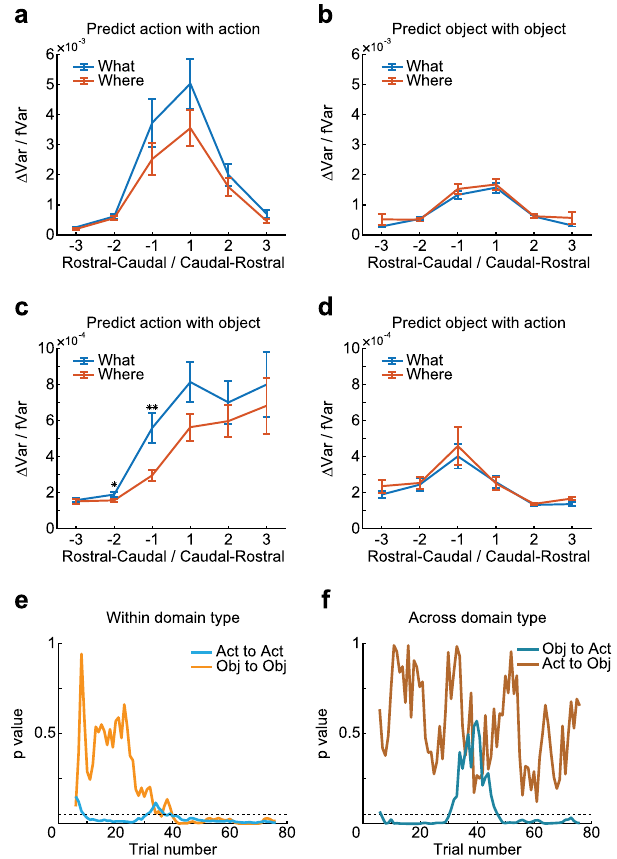
Fig. 6 Prediction of chosen action and object. a – d Contribution of arrays separated by different ordinal distances either rostral or caudal to each array to the prediction of posterior in each array. The x -axis indicates the ordinal distance (see Fig. 1d for array number) of the arrays that were dropped in the partial model. The y -axis indicates the difference of variance explained between the Partial models (i.e., when dropping one array, bilaterally) and the Full model ( Δ Var), normalized by the variance explained in the Full model (fVar). Larger values indicate a stronger prediction of the posterior from the arrays separated by distances indicated on the x -axis. The separate panels show the prediction of decoding accuracy of action with action ( a ), predicting object with an object ( b ), predicting action with an object ( c ), and predicting object with action ( d ). Rostral – caudal indicate information fl ow from rostral to caudal LPFC, labeled by negative ordinal distance; Caudal – rostral indicates information fl ow from caudal to rostral LPFC, labeled by positive ordinal distance. Error bars represent mean ± SEM, n = 32/64/96/96/64/32 for the ordinal distance of − 3/ − 2/ − 1/1/ 2/3. A two-sided t test was used to compare two populations, * p = 0.0383, ** p = 0.0032. e , f The p value of the difference in information fl ow between tasks (What and Where), aligned by the trial index, when doing predictions within ( e ) or across ( f ) domain type. Bin = 10 trials, step = 1 trial. Dash lines represent p = 0.05, Act represents action, Obj represents an object. Source data are provided as a Source Data fi le.